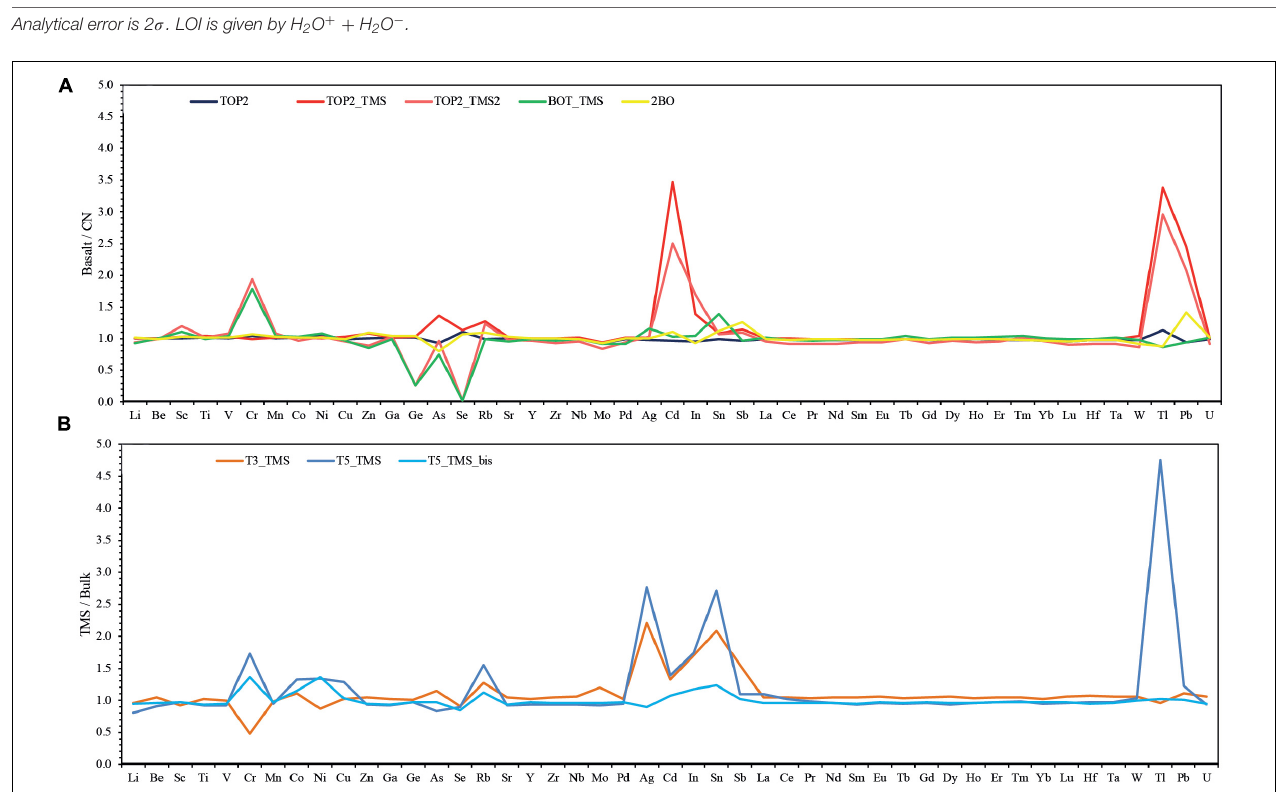
FIGURE 8 | Trace element diagrams for (A) samples in contact with tree as normalized to the control sample (CN); (B) the J74 lava flow: two samples in contact with tree (T3-TMS and T5-TMS) as normalized to their bulk composition (T3-bulk and T5-bulk, respectively).